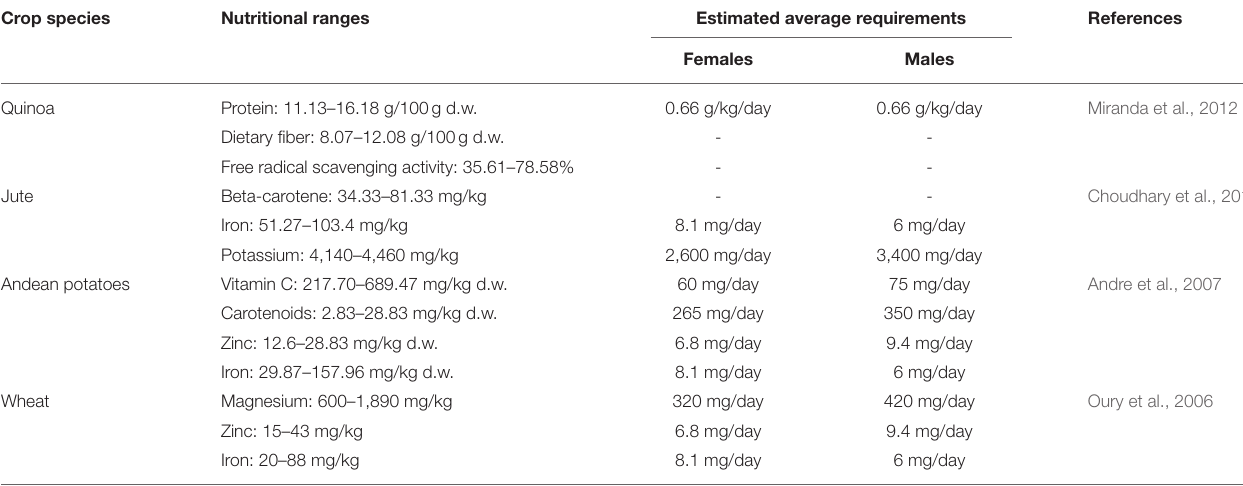
TABLE 2 | Examples of nutrient ranges within a single crop species, where d.w. refers to dry weight. Crop species Nutritional